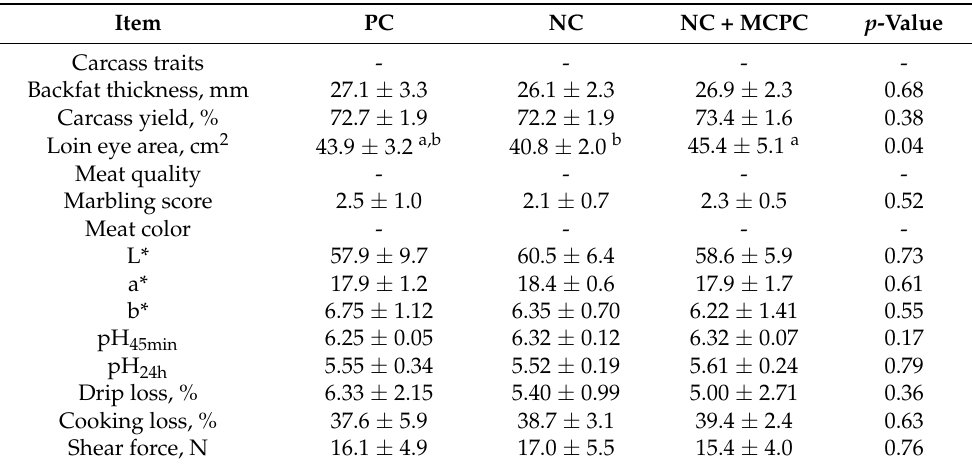
Table 5. Effect of the multicarbohydrase and phytase complex on the carcass traits and meat quality of pigs 1